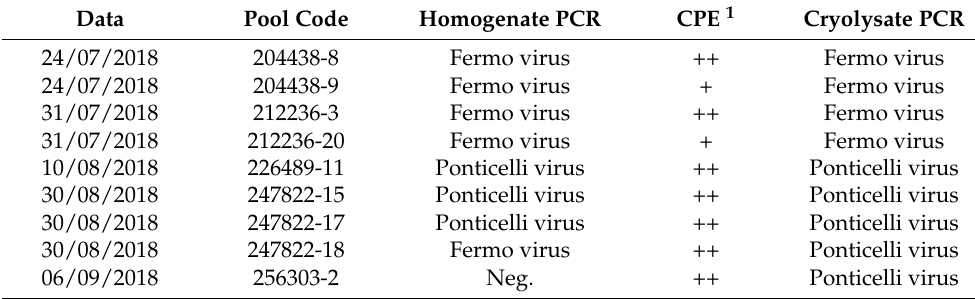
Figure 3. Neighbor joining tree of partial sequences of the S segments obtained from the field samples with reference to the strain collection day and utilization for isolation (i); the selected homologous sequences are available in GenBank (by referencing the accession number), bootstrap supports >90% showed near the branch. Table 3. Results of the analysis of the sand fly pools (25 specimens) with successful